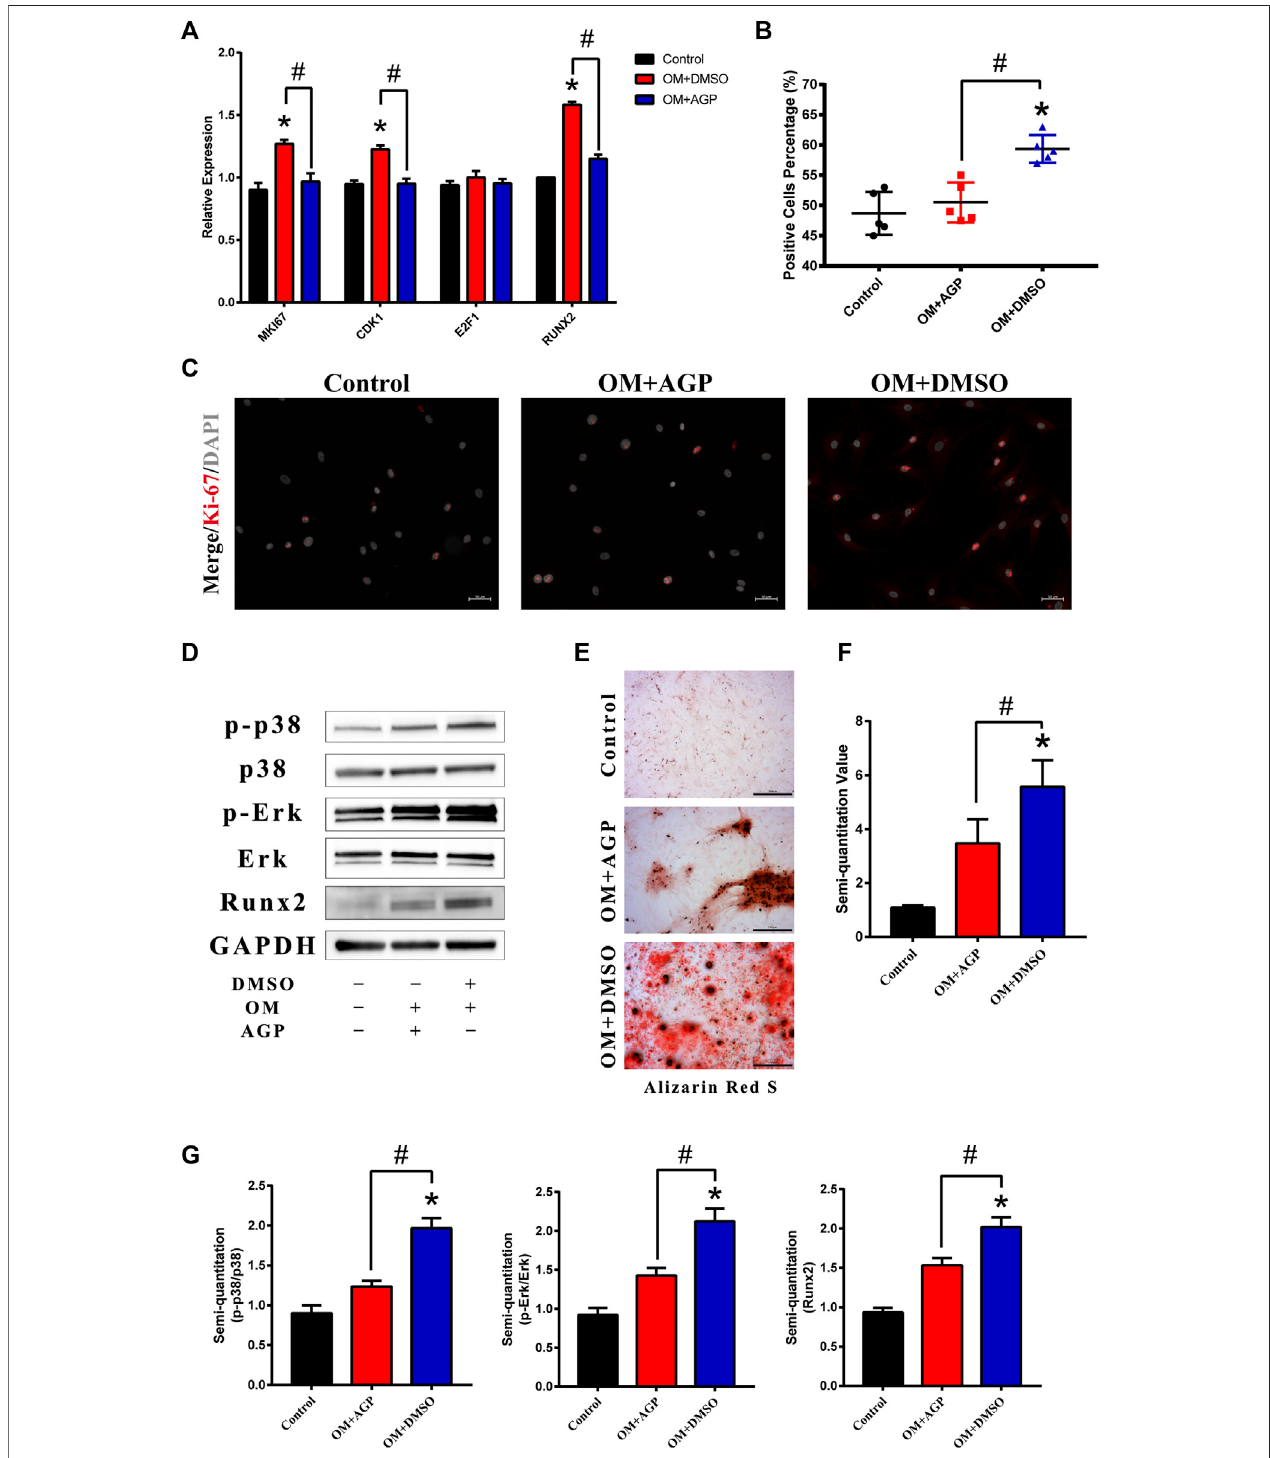
FIGURE4| AGPinhibitedcellproliferationinducedbyOMviatheMAPK-ERKpathway. (A) PCRtestforMKI67,CDK1,E2F1,andRunx2ofVICsstimulatedbyOM with or without AGP for 48 h. (B) Percentage of Ki-67 positive cells. (*) p < 0.05 (vs control) and (#) p < 0.05 (vs OM + DMSO) indicate signi fi cant difference. (C) Immuno fl uorescence stainingofMKI67 (red). (D) Westernblottingfor Runx2,phosphorylatedERK (p-ERK), total ERK, phosphorylated p38(p-p38),and totalp38 ofthe cellsstimulatedbyOMwithorwithoutAGPfor72 h. (G) StatisticalanalysisofproteinexpressionofRunx2,p38,andERKaccordingtothegraysemi-quanti fi cation compared to the GAPDH expression. (*) p < 0.05 (vs control) and (#) p < 0.05 (vs OM + DMSO) indicate signi fi cant difference. (E,F) Alizarin Red S staining and semi- quanti fi cation of VICs under different cultures: control, OM + DMSO, and OM + AGP (*) p < 0.05 (vs control). and (#) p < 0.05 (vs OM + DMSO) indicate signi fi cant difference ( n =